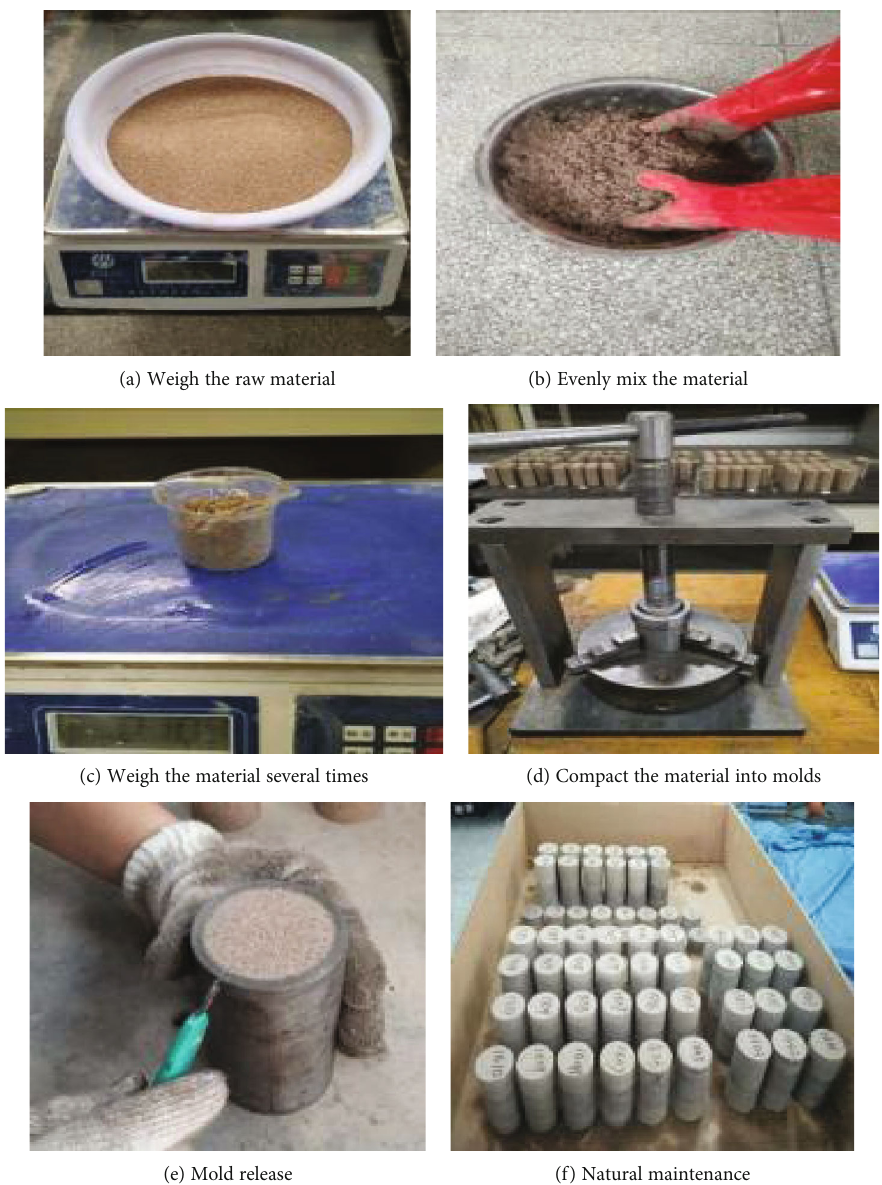
Figure 2: Sample preparation process.